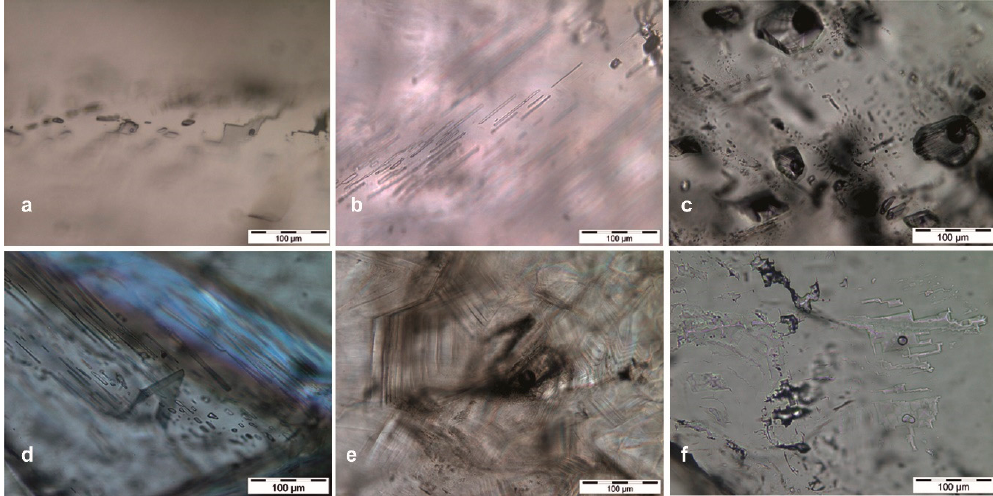
Figure 11. Fluid inclusion textures from investigated samples. ( a ) 2-phase FIs with irregular shape in calcite I (sample JAL-31). ( b ) Tube-like FIs parallel to twinning (calcite II, sample JAL-33). ( c ) Large 2-phase single FIs in calcite II (sample JAL-33). ( d ) Tube-like FIs parallel to twinning in calcite III (sample JAL-16B). ( e ) 2-phase inclusion entrapped between grain boundaries in chalcedony (sample JAL-32). ( f ) Irregular shaped 2-phase FIs in apophyllite (sample JAL-13D).